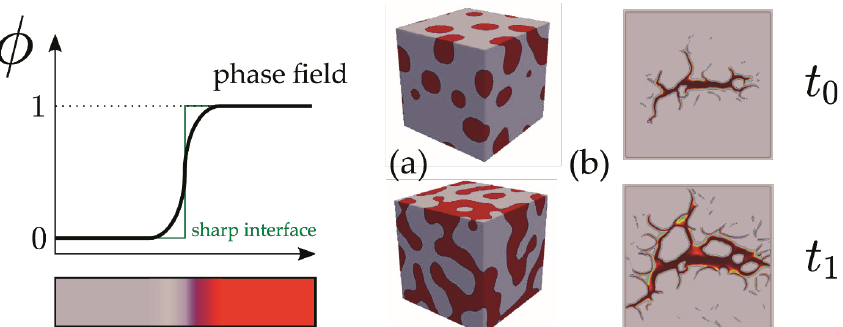
. Examples capturing (a) microstructural evolution [16], and (b) the , ). Adapted from 𝜙𝜙 𝑡𝑡 0 𝑡𝑡 1